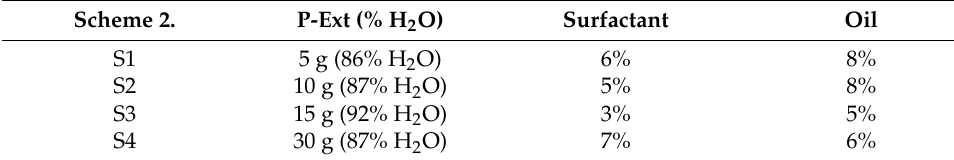
Table 2. The optimization chart of P-NE.